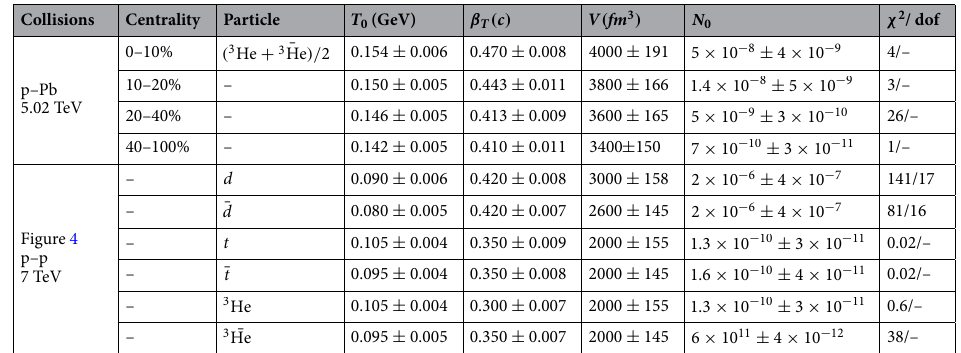
Table 1. List of the parameters. – is used in some places instead of dof. In fact it is not the fit result. if dof < 0, the we put – instead of negative values.